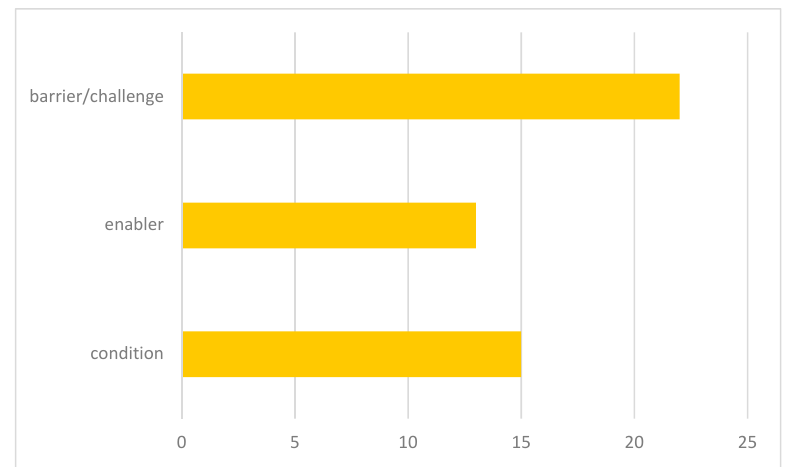
Figure 15. Progression factor distribution by role.